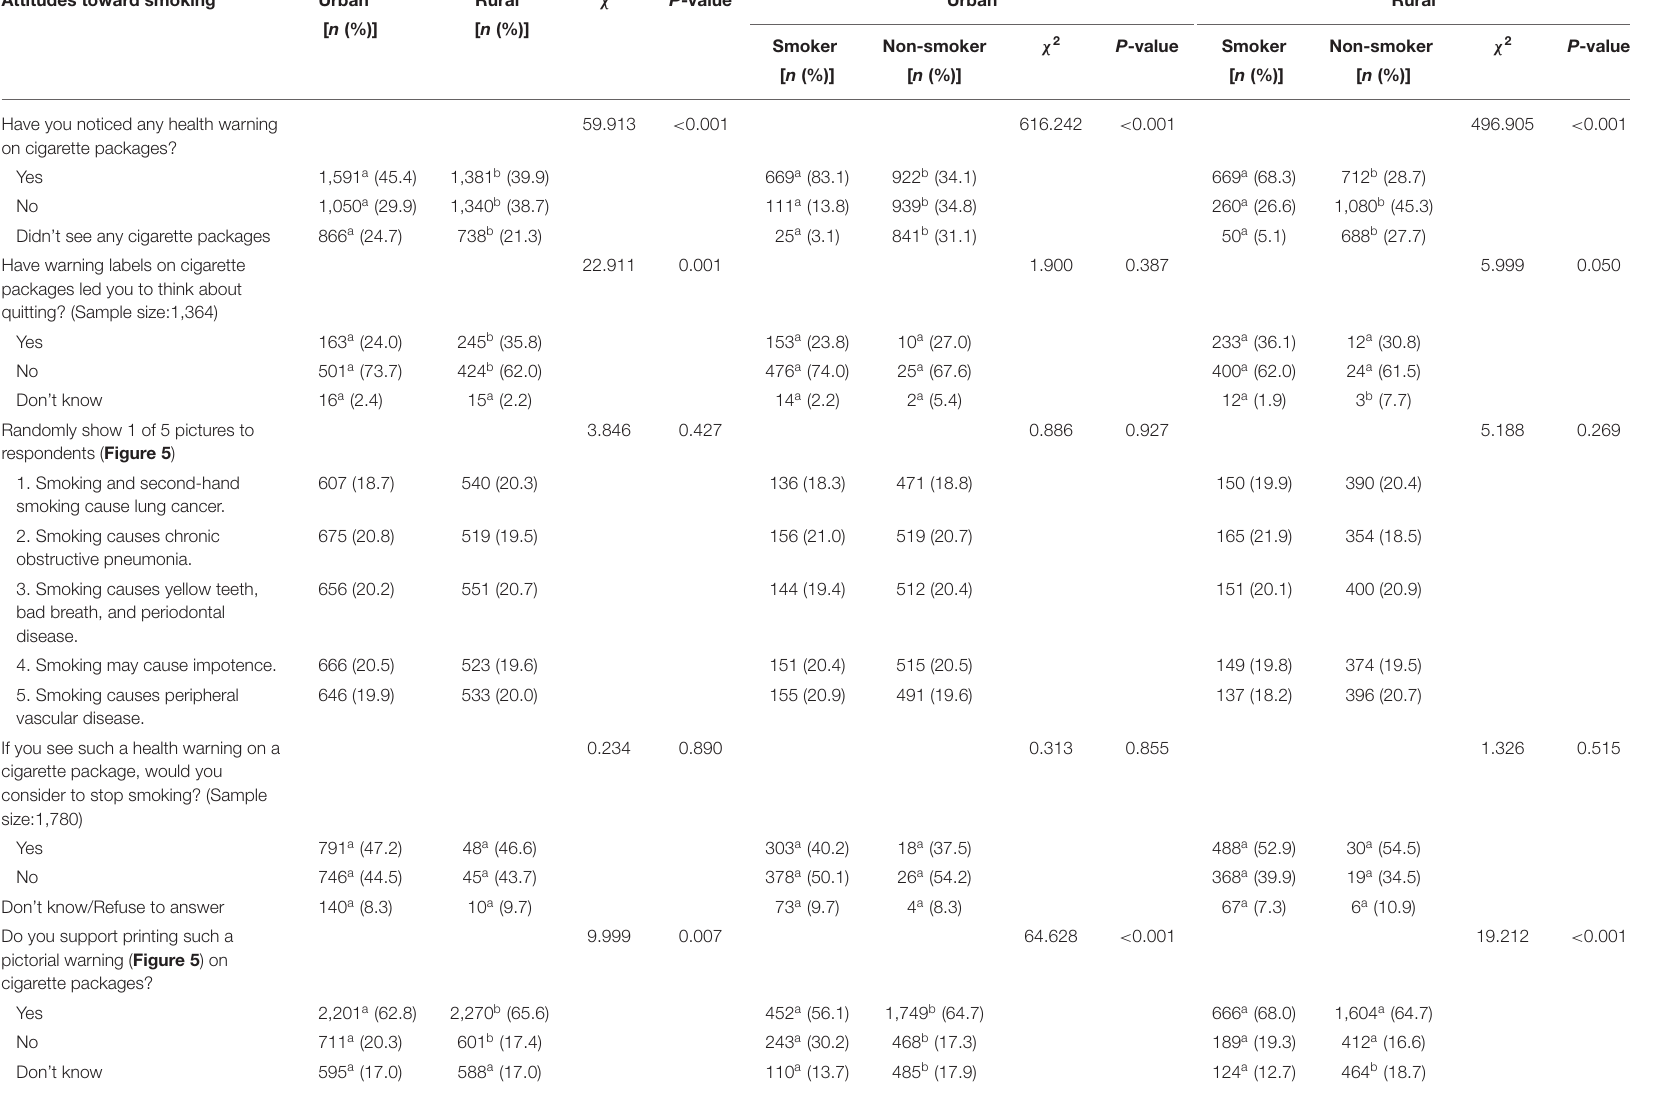
TABLE 4 | Responses to the health warning on cigarette packages among urban and rural elderly. Attitudes toward